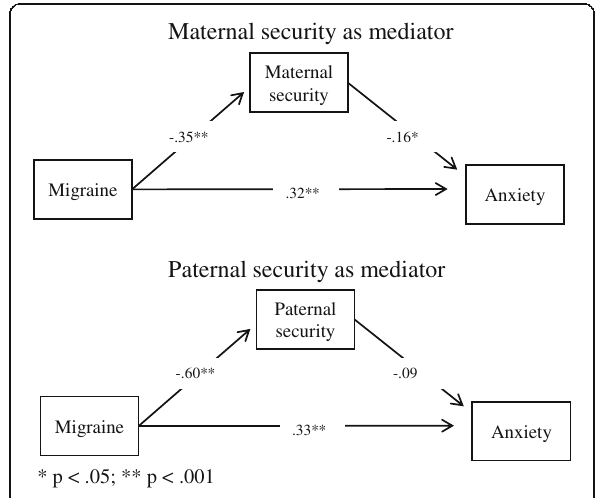
Fig. 1 Maternal security as mediator ( upper panel ), Paternal security as mediator ( lower panel